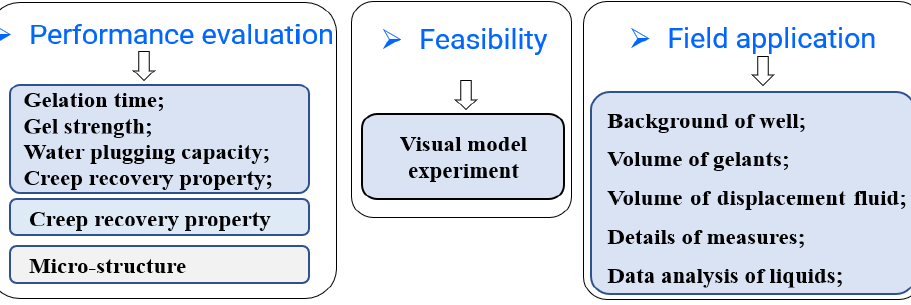
Figure 1. Flowchart of methodology.